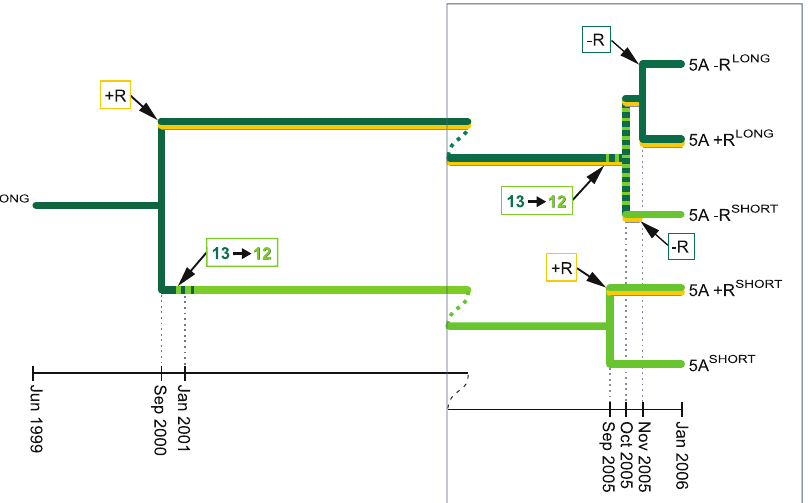
Figure 3. Chronology of ibpA Heat-Shock Promoter Evolution in Sublines of the 5A Line Line 5A was initiated from a single female in June 1999. In September 2000, it was transfected with a secondary symbiont to generate 5A þ R LONG . Subsequently the 5A line acquired the first mutation to the short promoter allele, which became fixed. An identical mutation rose to near fixation in the 5A þ R LONG culture in October 2005; both alleles were isolated from that colony to yield 5A þ R SHORT and 5A þ R LONG . Line 5A þ R SHORT lost its Candidatus Serratia symbiotica to generate line 5A (cid:2) R SHORT , and then in November 2005, 5A þ R LONG was cured of Candidatus Serratia symbiotica to generate line 5A (cid:2) R LONG . Thus the mutation occurred and rose to fixation or near fixation twice in sublines of the 5A laboratory line (Figure 1B).